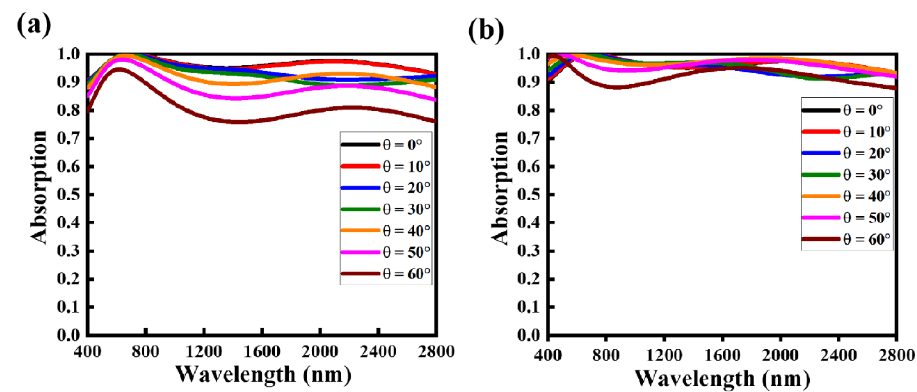
Figure 6. Optical absorption rate of the proposed NMMA under the variation of incident angles of the incoming light: ( a ) TE-wave polarized optical light and ( b ) TM-wave polarized optical light.